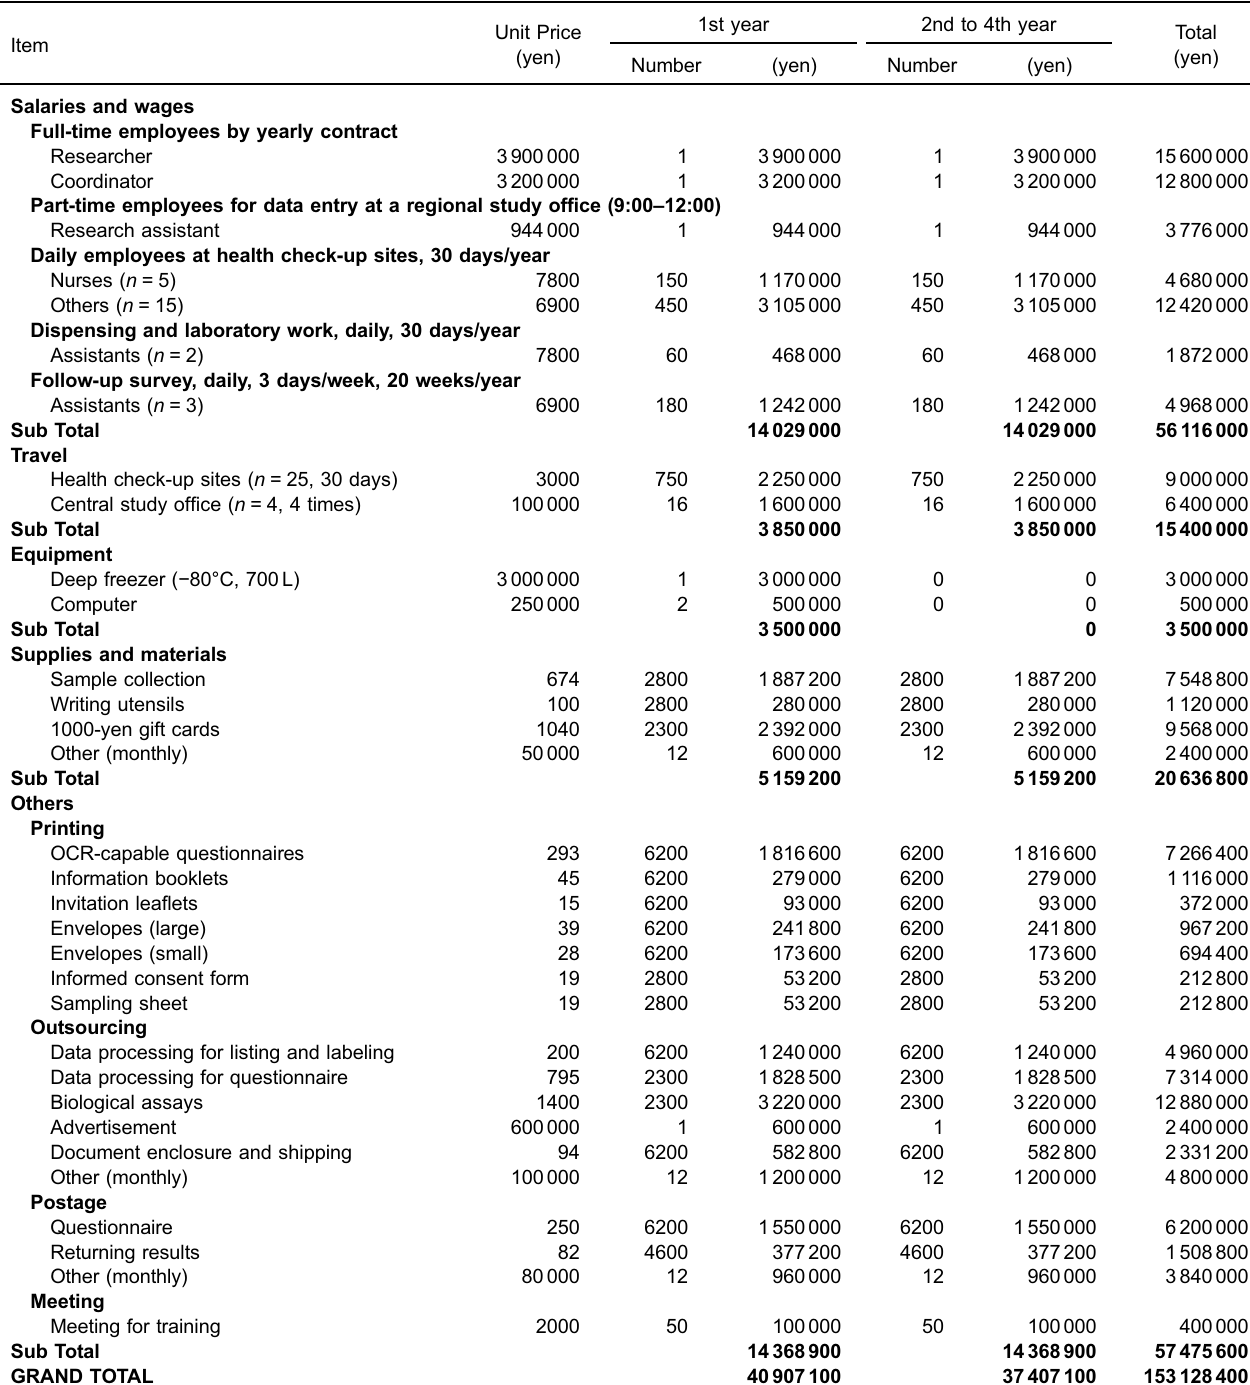
Table 3. Cost estimation in a regional study of fi ce